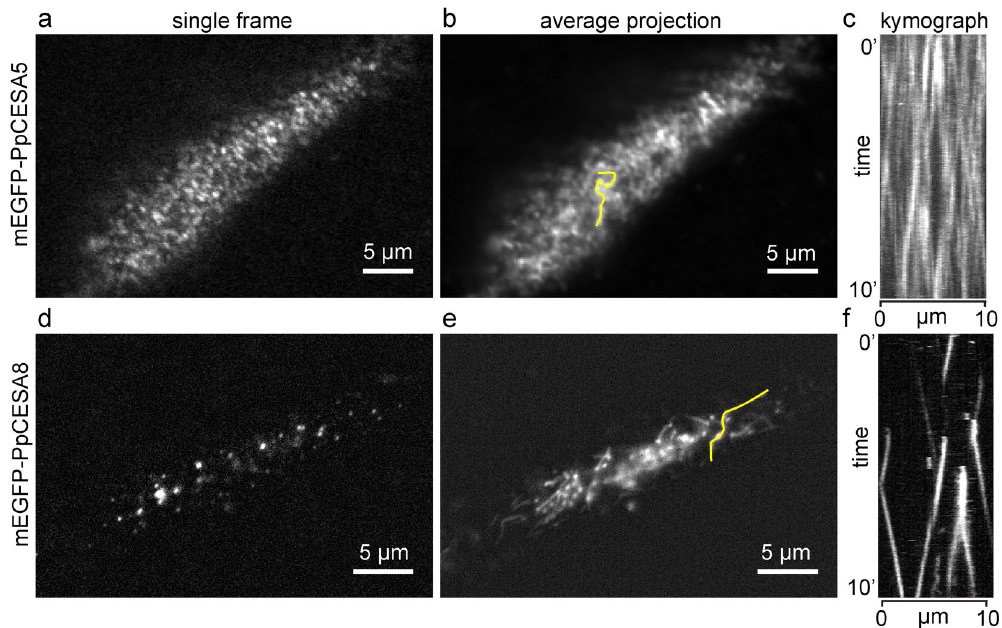
Figure 2. Imaging particle motility for mEGFP-PpCESA5 and mEGFP-PpCESA8. ( a , d ) Single frames from 10 min time-lapse imaging experiments. ( b , e ) Average projections of time-lapse images, with lines used to generate kymograph in yellow. ( c , f ) Kymographs of particle movement along lines in ( b ) and ( e ); diagonal lines represent movement over time. Images were acquired with VAEM with 2 s time